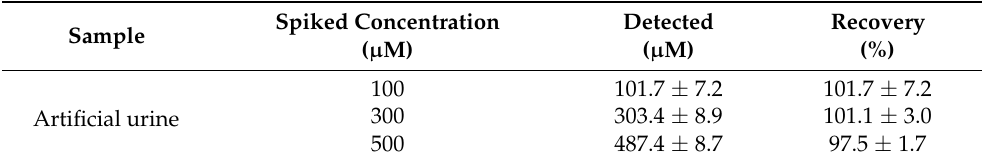
Table 1. Determination of spiked TMAO in artificial urine samples using the proposed colourimetric assay, which is based on the PAH@MnO 2 nanozyme.